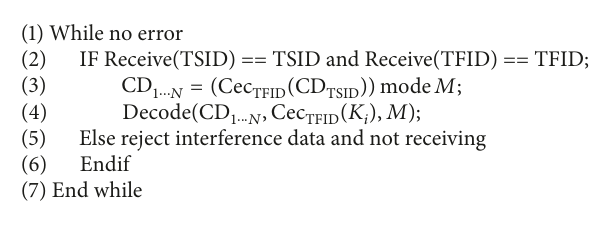
Algorithm 3: Data fusion recovering of head